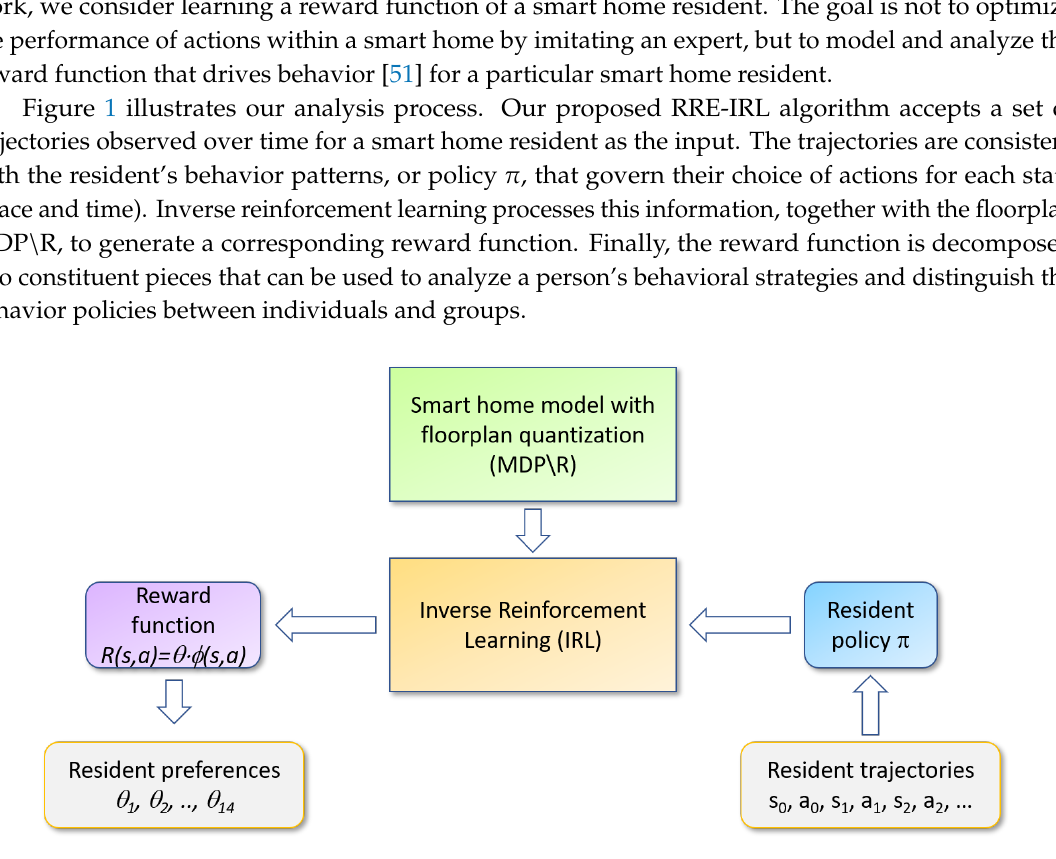
Figure 1. Resident Relative Entropy-Inverse Reinforcement Learning (RRE-IRL) analysis of smart home sensor data.